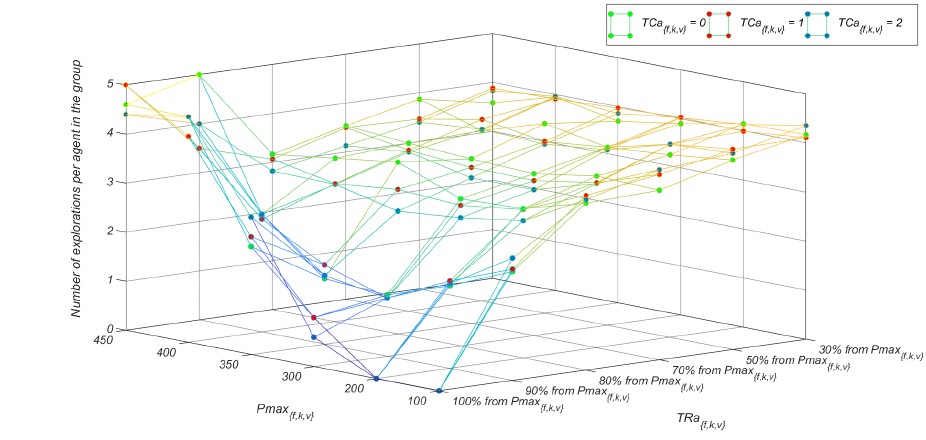
Figure 5. The average number of explorations per agent at the 10,000th iteration: TPea { f , k , v } = 3 ∗ Pmax { f , k , v } , Pa { f , k , v } = Pmax { f , k , v } , and the exploration space was 10 × 8 × 5